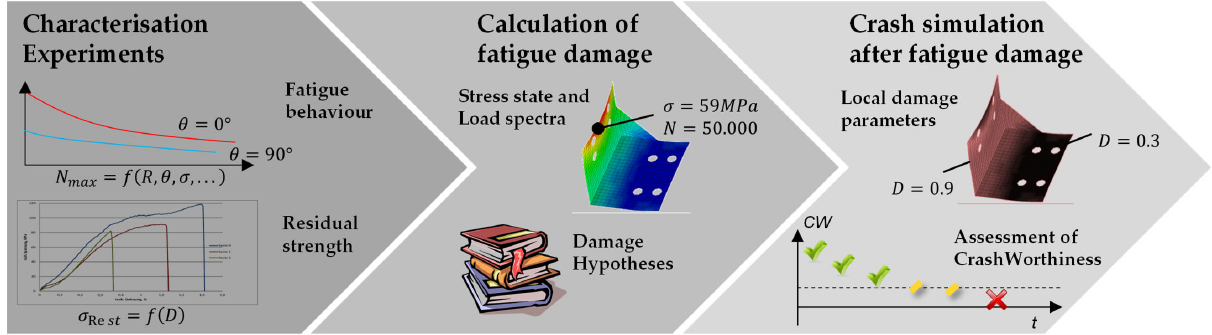
Figure 2. Main steps of the modelling approach.